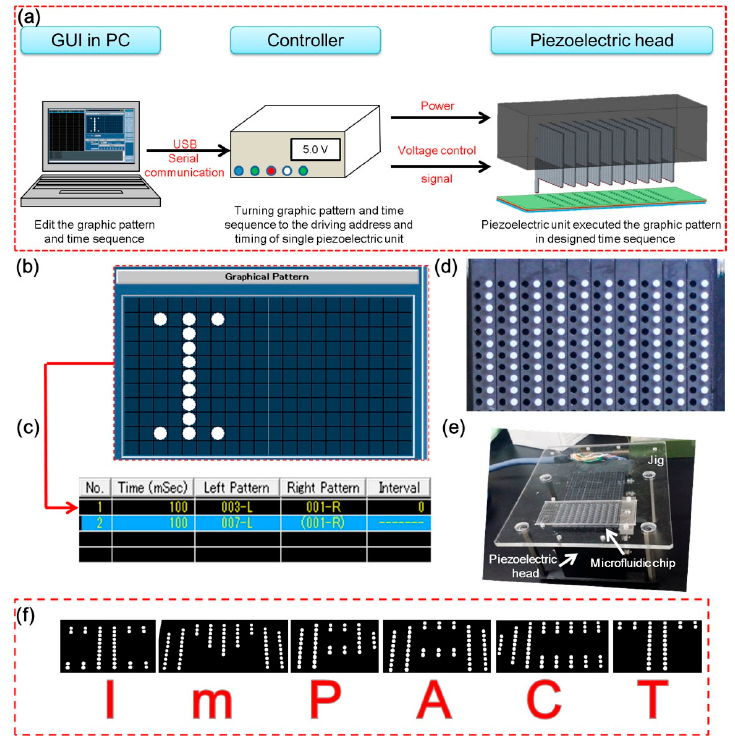
Figure 3. Piezoelectric actuator system for individual control of the all-glass valve. ( a ) The actuator system consists of three parts: a PC (with an installed graphic user interface (GUI)), a customized circuit board-based controller (with power and control signals), and a piezoelectric head; ( b ) Graphical pattern of activated valve locations; ( c ) Time-sequence-editing by the GUI; ( d ) Piezoelectric head with 110 piezoelectric units in an 11 ˆ 10 array; ( e ) Fully assembled image of piezoelectric head, microfluidic device, and acrylic mounting jig; ( f ) Captured image from the demonstration of a word pattern displayed by the piezoelectric